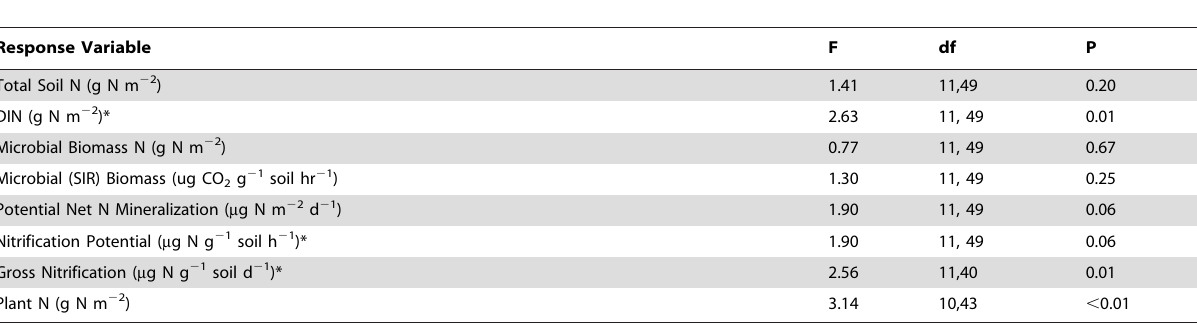
Table 2. Effect of plant species on soil N pools and process rates.